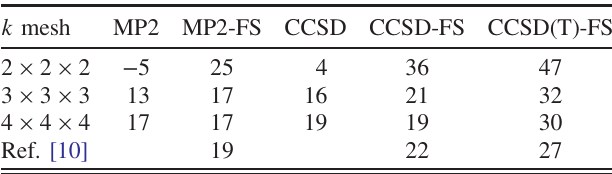
TABLE I. Cohesive energies of solid neon obtained using MP2, CCSD, and CCSD(T) theory. The summarized results have been extrapolated to the complete basis set limit using pseudized aug- cc-pV(D,T)Z basis sets and corrected for basis-set superposition errors using counterpoise corrections. All units are in meV = atom. k mesh